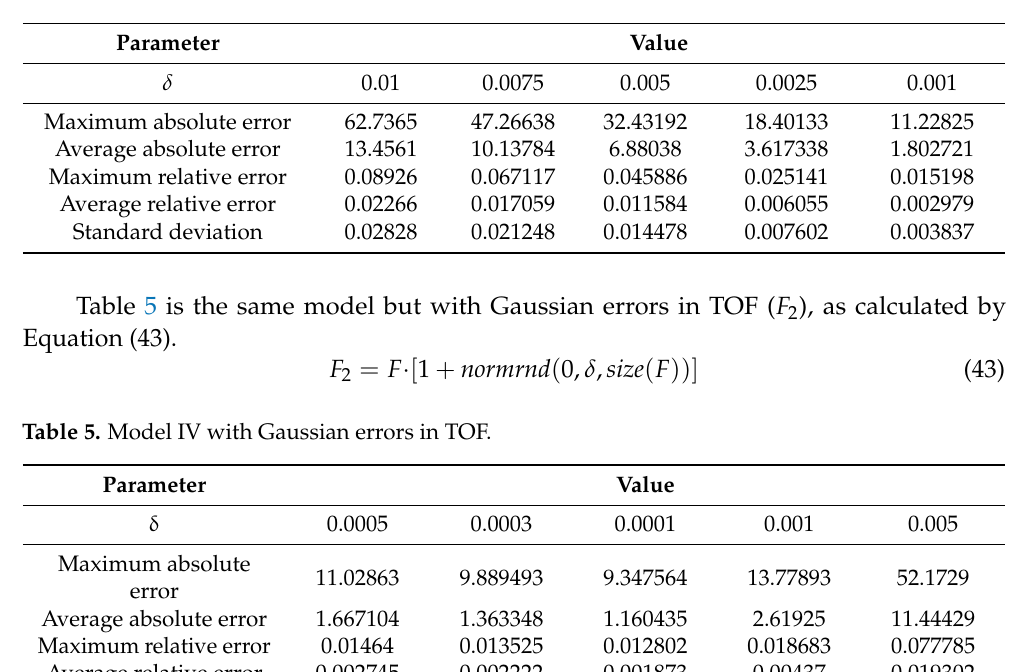
Table 4. Model IV with errors in TOF.